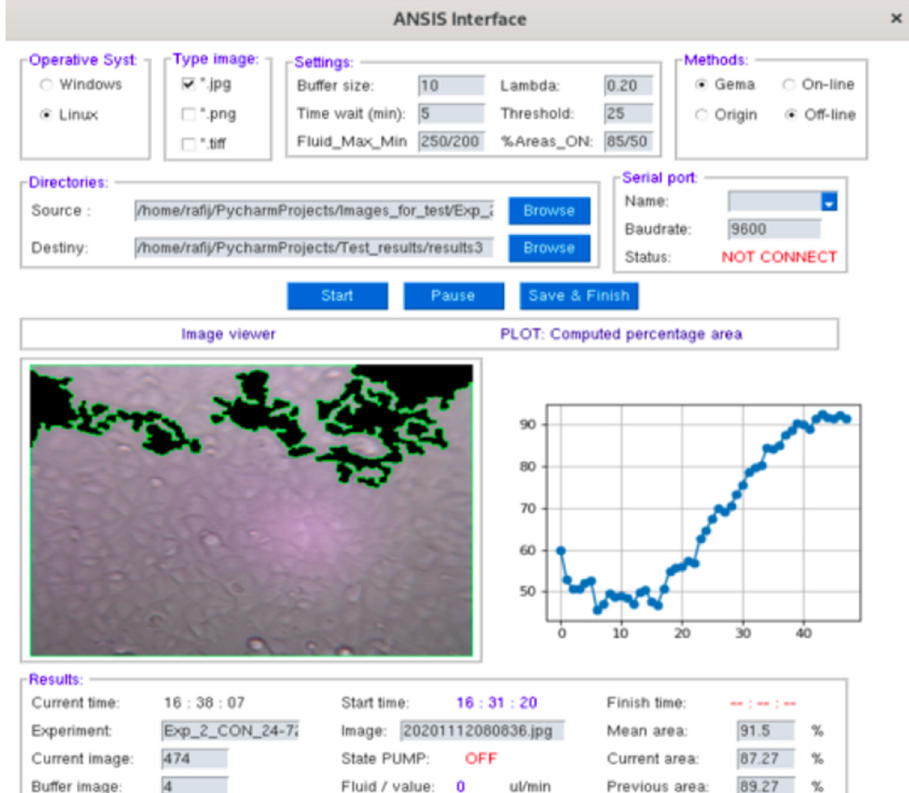
Figure 13. The ANSIS interface to control and analyze the evolution of biological experiment in real- time using